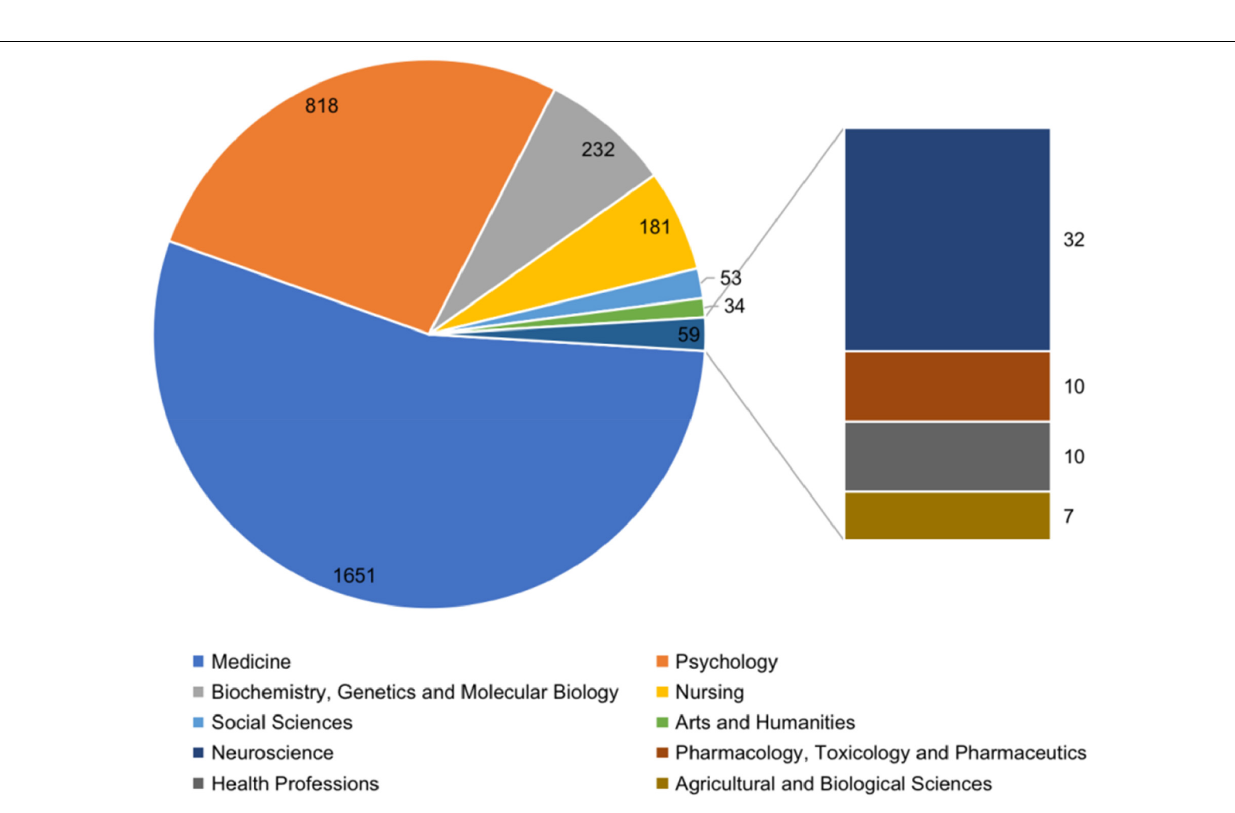
FIGURE 8 | Most studied subject areas in psycho-oncology between 1980 and